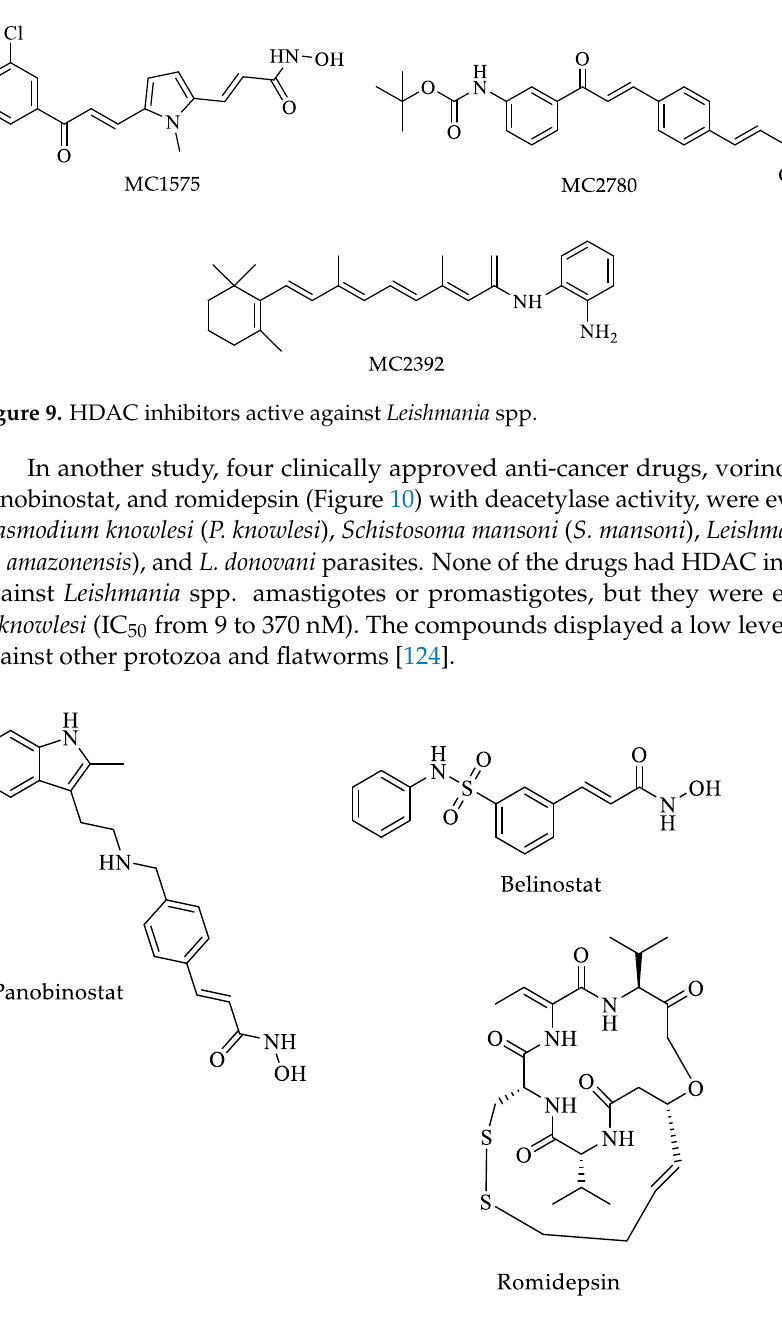
Figure 10. Anticancer drugs evaluated as HDAC inhibitors against four protozoa.